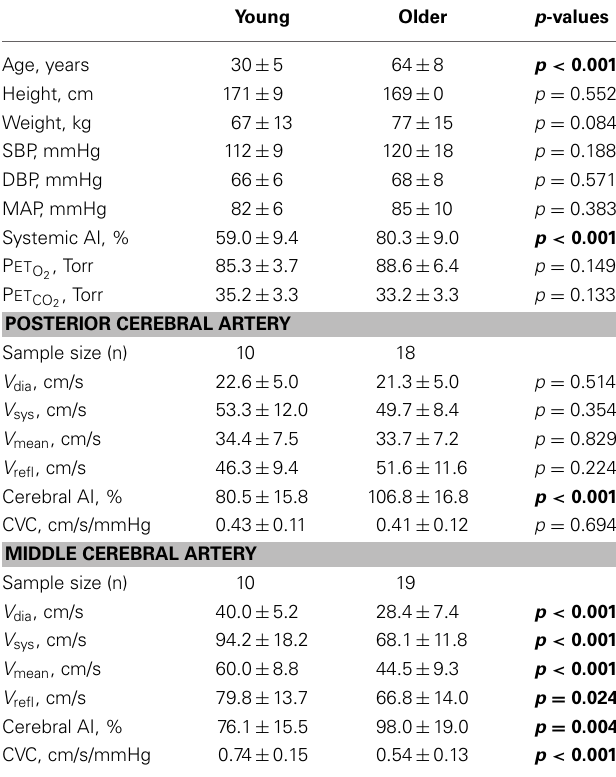
Table 1 | Demographics of the study cohort and resting end-tidal partial pressures of O 2 and CO 2 , and cerebral hemodynamic indices in the posterior and middle cerebral